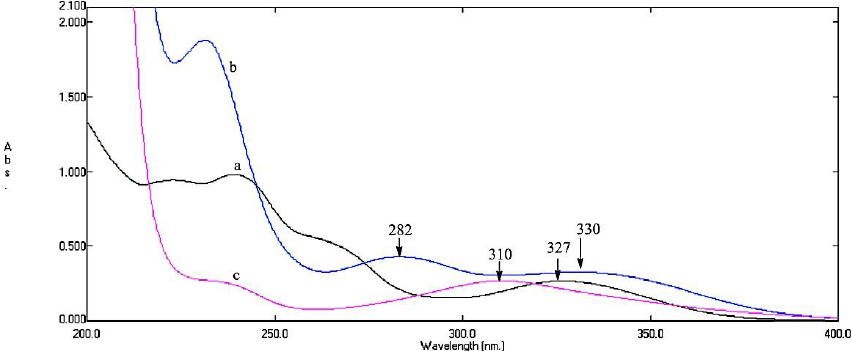
Figure2. Zero-orderabsorptionspectraof( a )20 µ gmL − 1 CS,( b )30 µ gmL − 1 Deg1and( c )30 µ gmL − 1 Figure 2. Zero-order absorption spectra of ( a ) 20 μg mL −1 CS, ( b ) 30 μg mL −1 Deg1 and ( c ) 30 μg mL −1 Deg2.